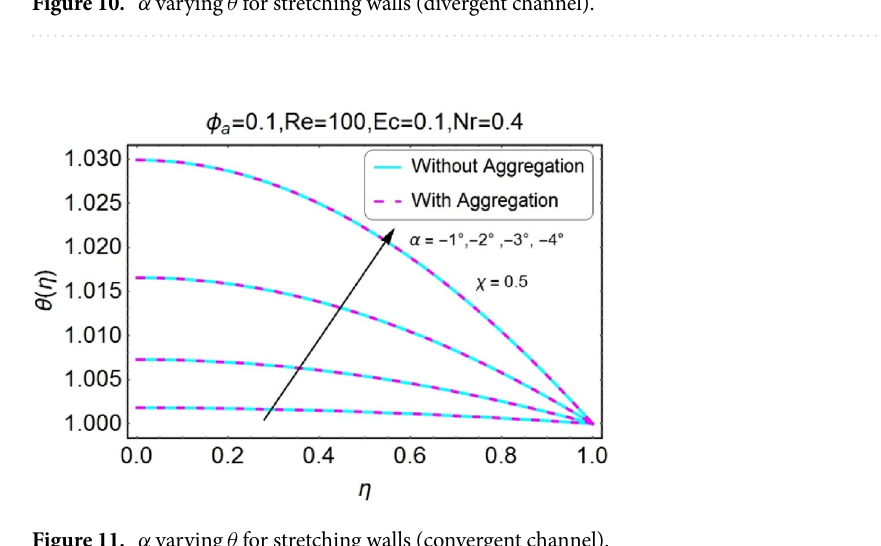
Figure 10. α varying θ for stretching walls (divergent channel).